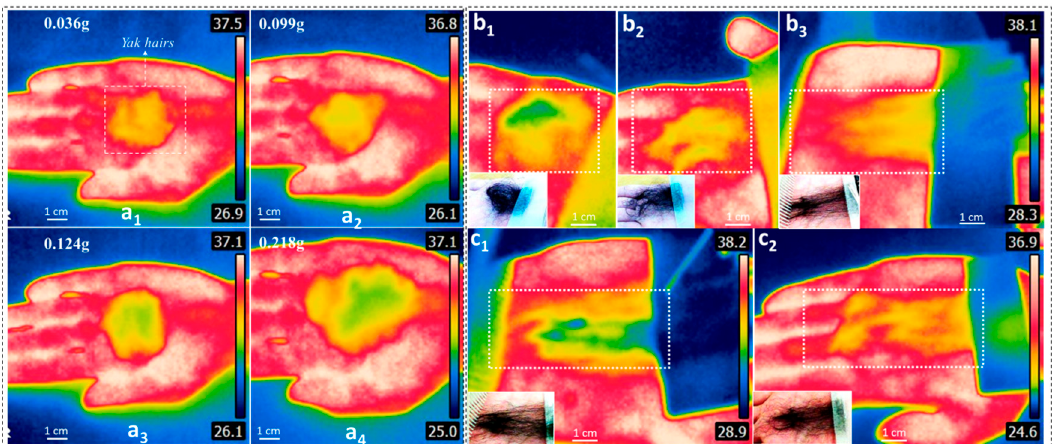
Figure 8. Thermal insulation properties of yak hairs with infrared images for ( a ) the measured relationship of hair weight (a 1 -0.036 g; a 2 -0.099 g; a 3 -0.124 g; a 4 -0.218 g) and temperature contour of hairs on a human hand (a kind of constant temperature source); ( b ) thermal insulation corresponds to hair states that (b 1 ) shows hairs rubbed into a ball shape, (b 2 ) shows hairs in natural state, and (b 3 ) shows hairs in fully stretched straight state; ( c ) the fully stretched hairs in wet (c 1 ) and dry (c 2 ) states, using shape memory function.